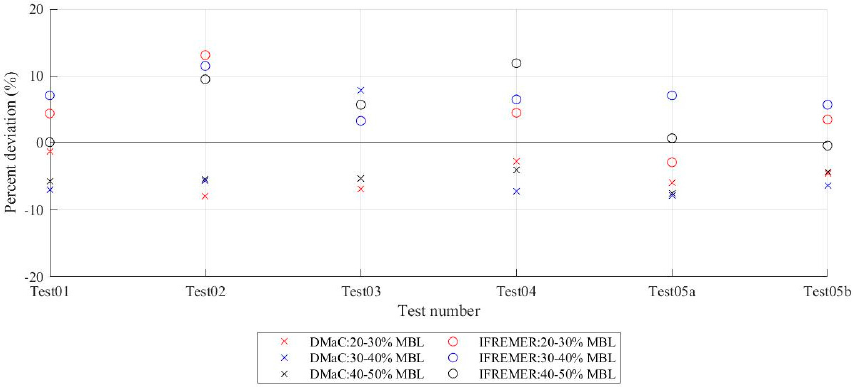
Figure 9. Percent deviation of dynamic stiffness at load ranges of 20–30% MBL, 30–40% MBL and 40– 50% MBL, from mean stiffness values of 31.4 kN/%, 34.5 kN/% and 37.5 kN/%, respectively.